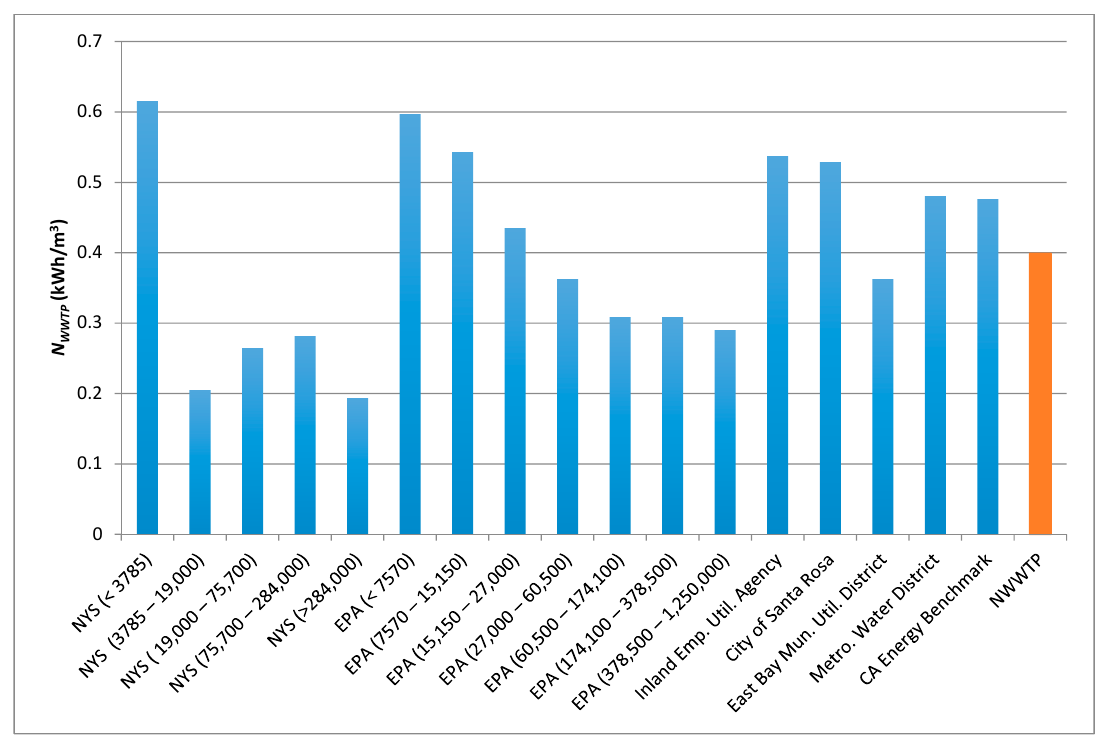
Figure 1. Energy consumption per unit volume ( N WWTP ) for a given wastewater treatment plant (WWTP). NYS, New York State; EPA, United States Environmental Protection Agency; CA, California. Values inside parentheses indicate flow (m 3 /day).